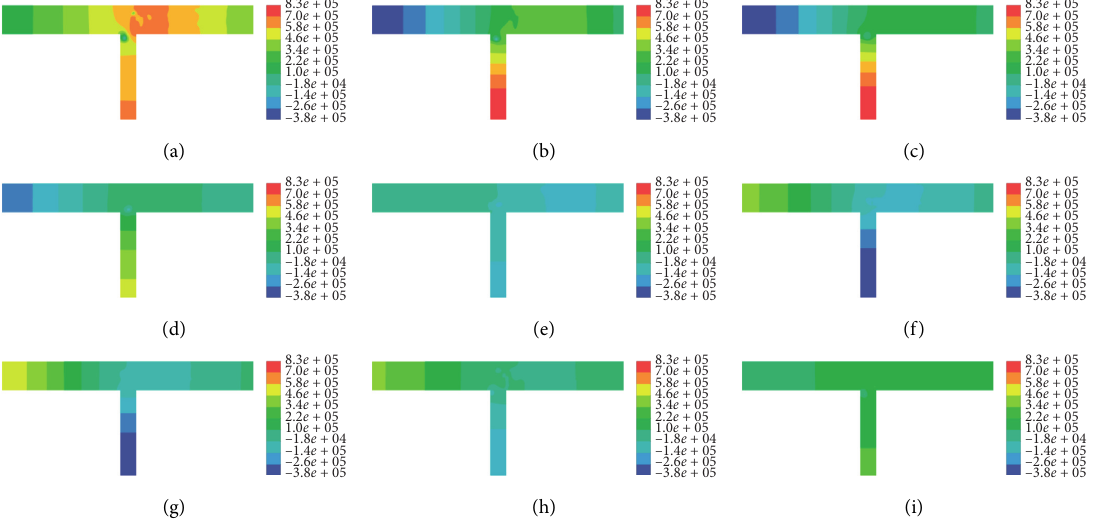
Figure 14: Pressure contour ( t 3 � 1.7s–1.72 s, unit: Pa): (a) 0T/8, (b) 1T/8, (c) 2T/8, (d) 3T/8, (e) 4 T/8, (f) 5T/8, (g) 6 T/8, (h) 7 T/8, and (i)